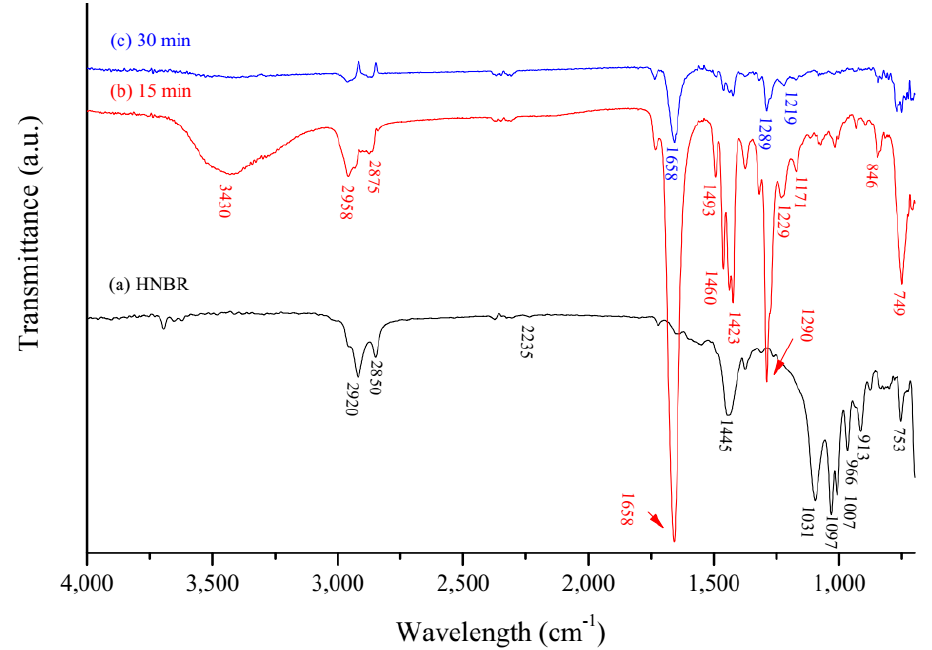
Figure 2. ATR-FTIR spectra of: ( a ) pristine hydrogenated nitrile butadiene rubber (HNBR), HNBR after immersion in a PVP:CHCl 3 solution for ( b ) 15 min and ( c ) 30 min and quenching in hexane for 30 min.